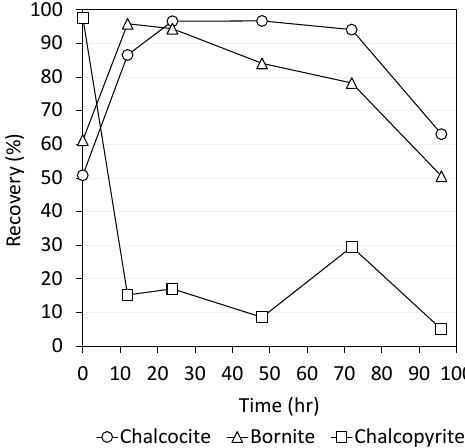
Figure 3. The flotation recoveries of chalcocite, bornite, and chalcopyrite after oxidation treatments at 0, 12, 24, 48, 72, 96 h at pH 9.